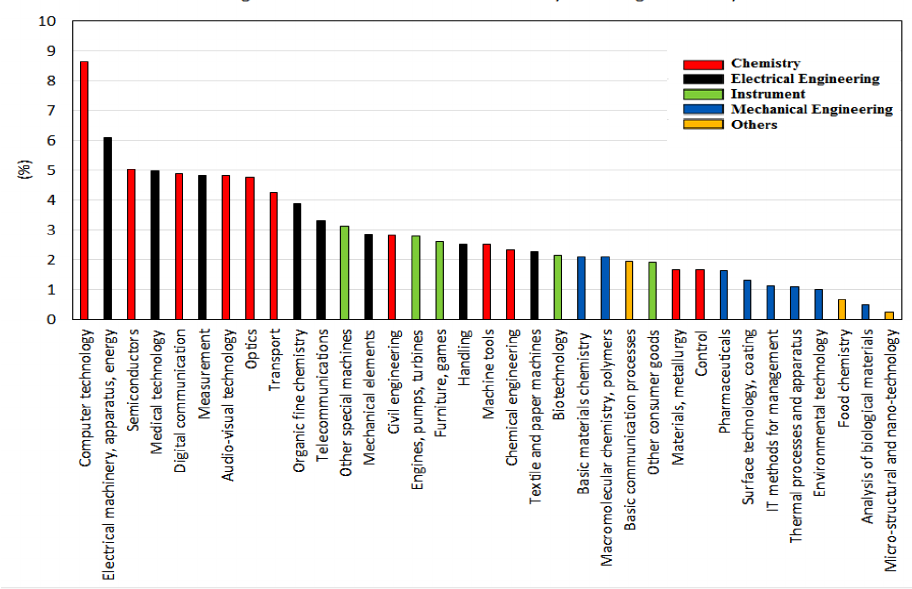
Figure 1. Percentages of the 35 technological